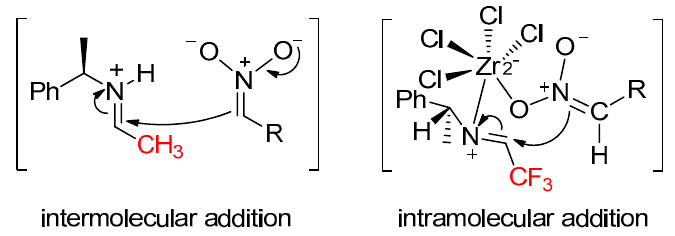
Figure 1. Different possible mechanisms.